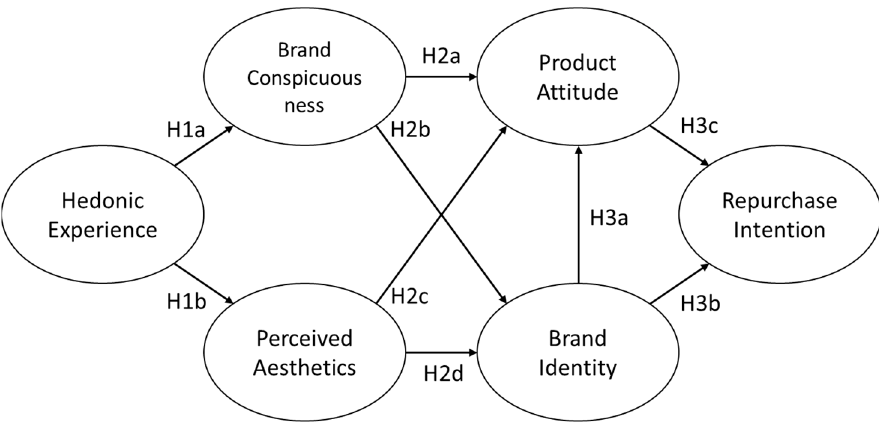
Figure 2. Theoretical framework and hypotheses.